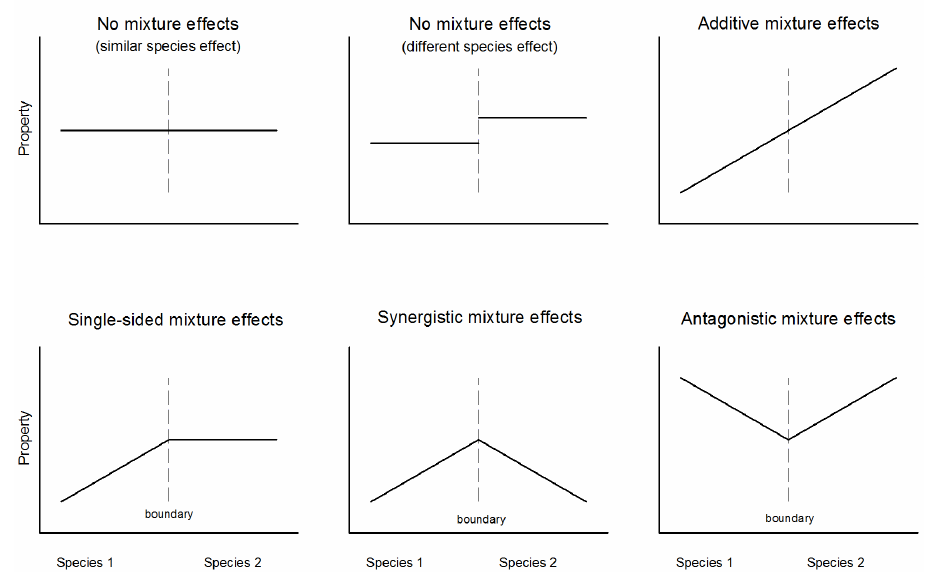
Figure 2. Conceptual graphs showing possible mixture effects in a transboundary design in adjacent common garden stands of two tree species.